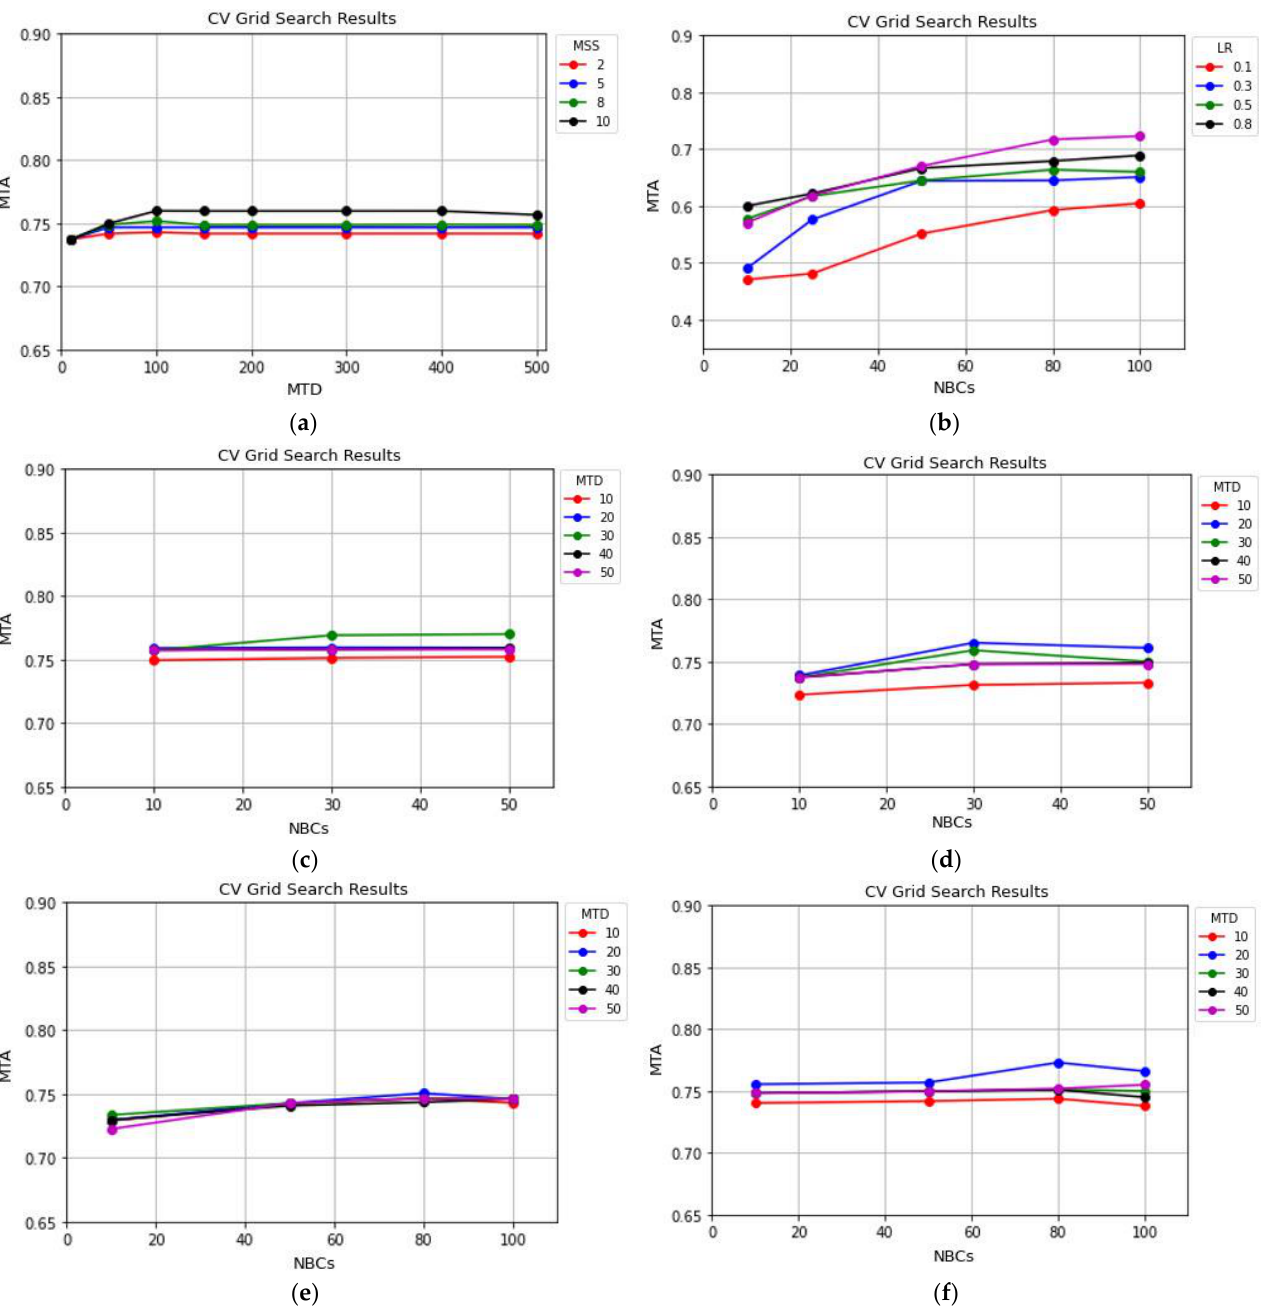
Figure 11. Hyper-parameter analysis of different EL methods using ISPRS Vaihingen data. ( a ) DT, ( b ) AdaBoost, ( c ) GBM, ( d ) XGBoost, ( e ) LightGBM, and ( f ) RF.